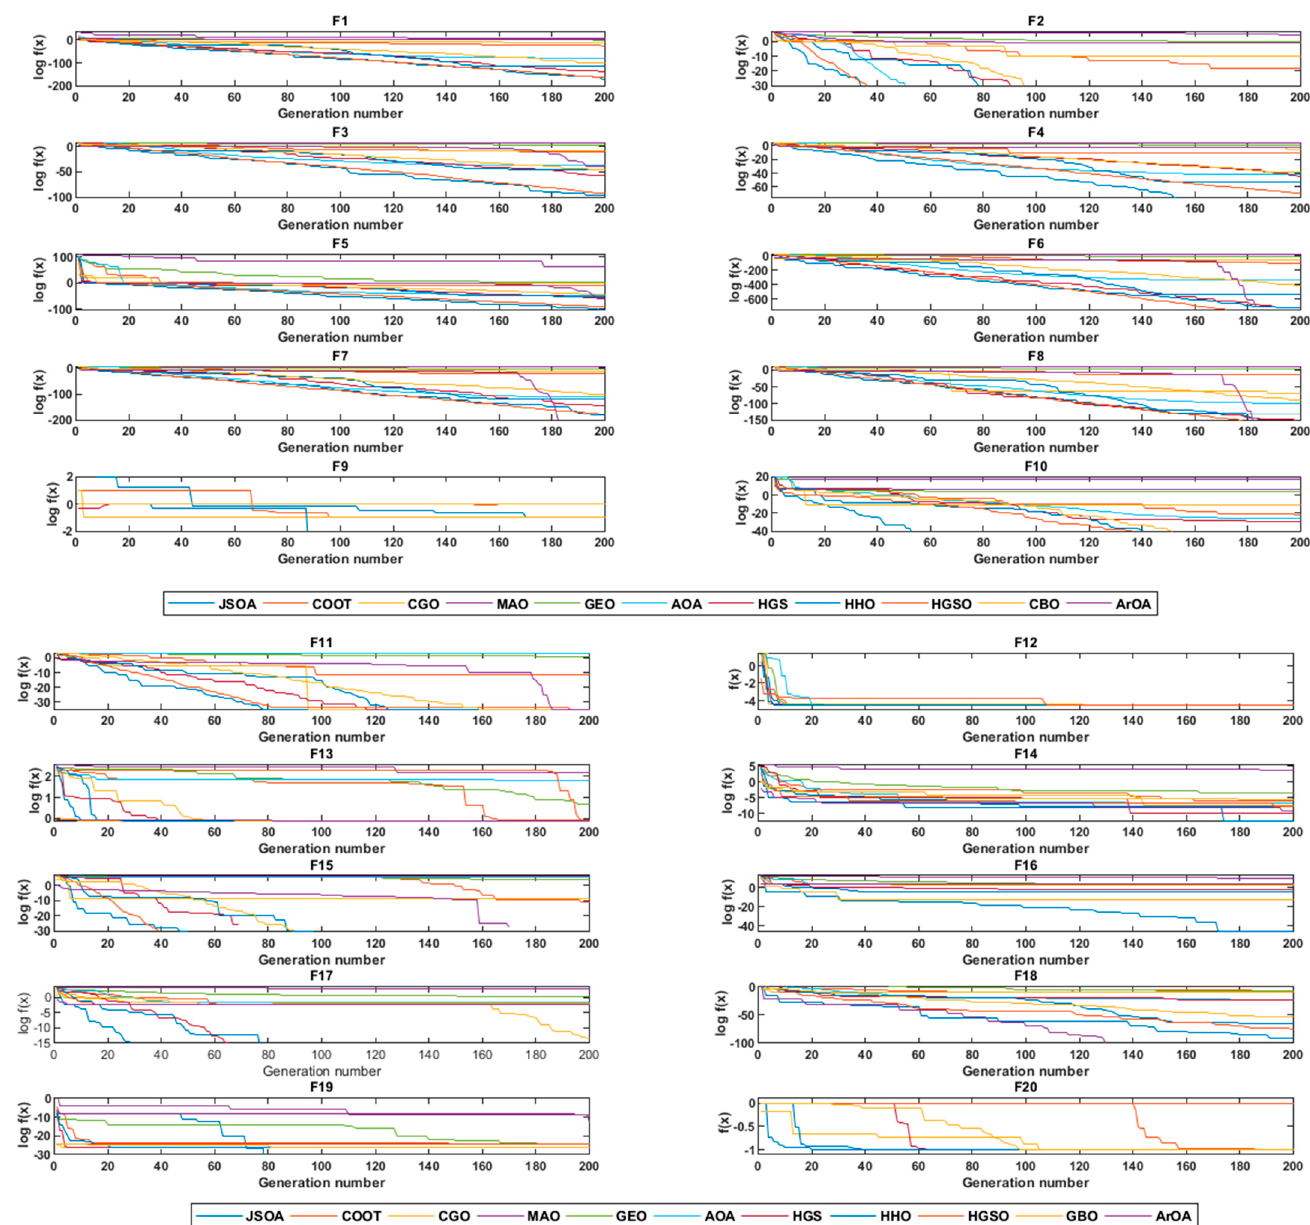
Figure 10. Convergence curves. Table 2. JSOA—Performance and comparison.